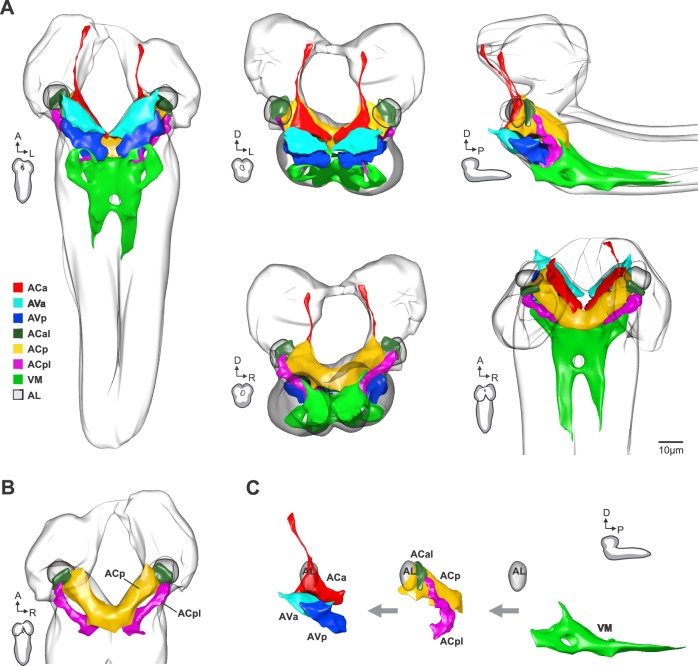
Sensory compartments.(A) Glomerular-like compartmentalization of the supesophageal zone (SEZ). Non-overlapping digital 3D models delineate compartments based on synapse similarity score. (B) The ACpl (posterior lateral part of the Anterior Central sensory compartment) with 14 neurons which laterally flanks the ACp (primary gustatory center) delineate a so far undescribed sensory compartment in the larva (comparable to antenno-subesophageal tract ‘AST’ in adults (Ito et al., 2014). (C) Expanded view of partly intermeshed sensory compartments (Digital 3D models), subgrouped into monosynaptic reflex module (ACa, AVa and AVp, also see Figure 3), mushroom body module (AL, ACal, ACp and ACpl, also see Figure 6) and somatosensory compartment (VM). List of compartment names, abbreviations and color code.